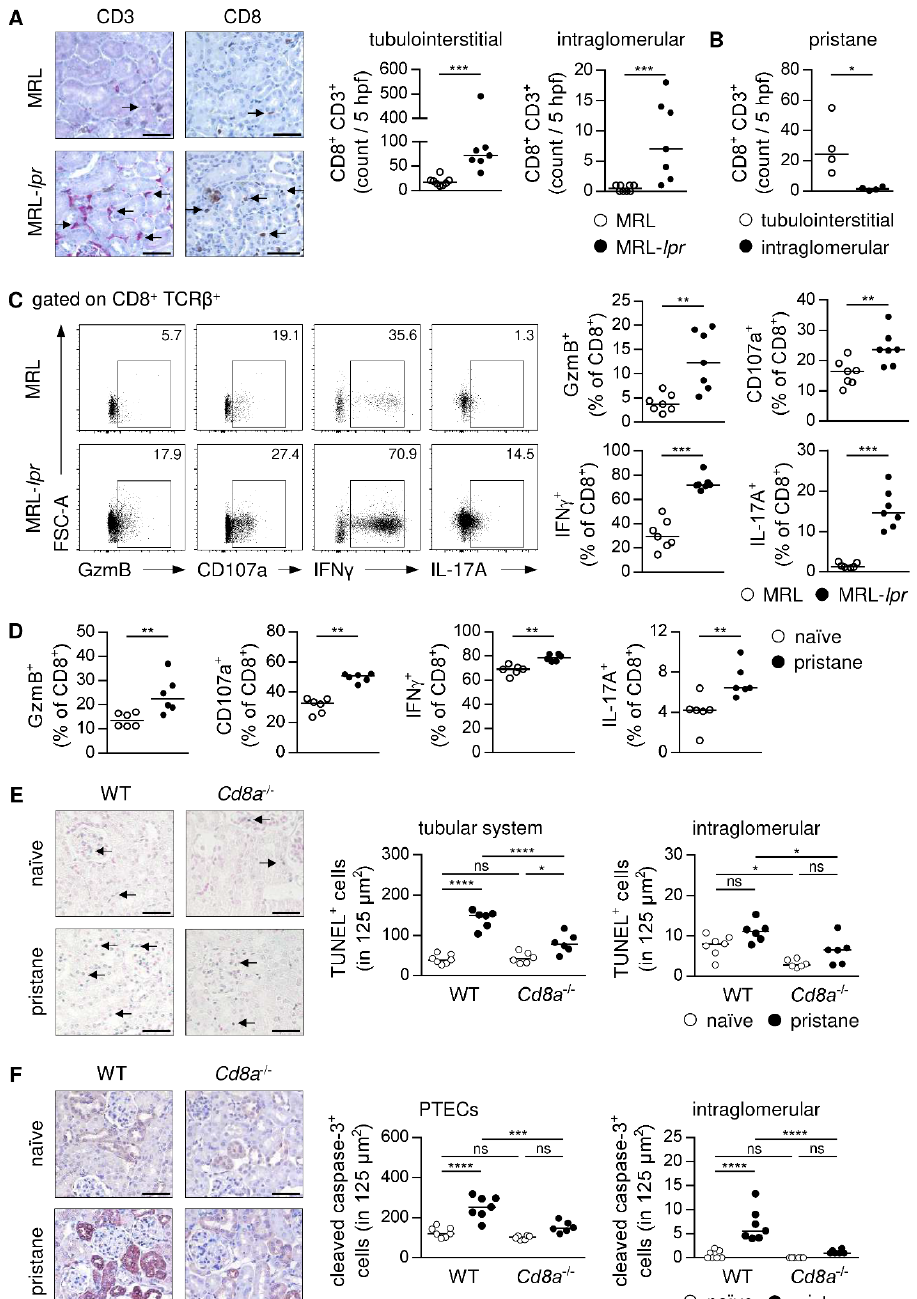
Figure 8. CD8 + T cell-dependent apoptosis in murine lupus nephritis. Serial kidney sections of ( A ) lupus-prone MRL- lpr mice and ( B ) pristane-treated WT mice were stained with anti-CD3 or anti-CD8 antibodies. Number of tubulointerstitial and intraglomerular CD8 + CD3 + T cells were counted in 5 hpf per section. Arrows mark CD8 + T cells. ( C ) Phenotype of renal CD8 + T cells was analyzed in MRL- lpr mice and ( D ) pristane-treated WT mice by flow cytometry. ( E ) Number and localization of renal apoptotic cells and ( F ) cleaved caspase-3 + cells were analyzed by TUNEL assay or cleaved caspase-3 staining in pristane-treated WT and Cd8a − / − mice. Bars represent 50 µ m. Representative dot plots and medians of one out of two experiments are shown. * p < 0.05; ** p < 0.01; *** p < 0.001; **** p < 0.0001, ns: not